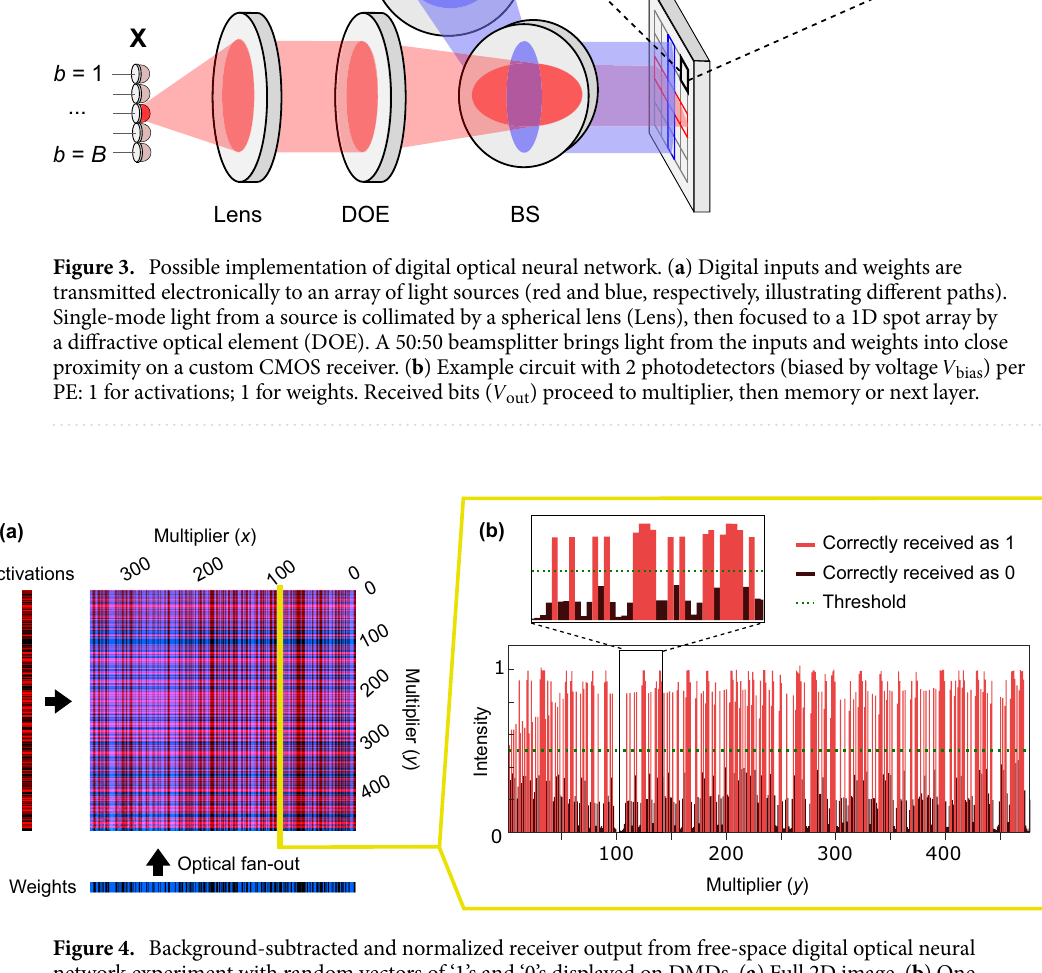
Figure 4. Background-subtracted and normalized receiver output from free-space digital optical neural network experiment with random vectors of ‘1’s and ‘0’s displayed on DMDs. ( a ) Full 2D image. ( b ) One column: pixels received as ‘1’ in red and ‘0’ in